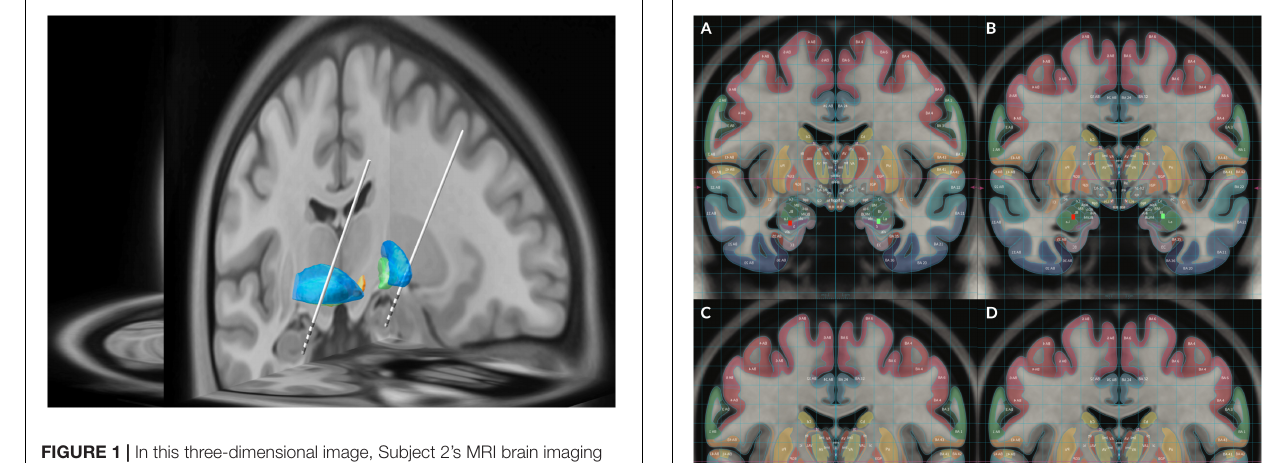
FIGURE 1 | In this three-dimensional image, Subject 2’s MRI brain imaging studies were registered to the MNI space (MNI152 NLIN2009a) and then overlaid on the structural atlas of Mai (Horn and Kühn, 2015; Mai and Majtanik, 2017). Here we demonstrate the trajectory for each DBS electrode implanted into the head of the HC and amygdala as represented in “MNI space.” The blue regions represent the putamen while the green regions represent the globus pallidus. The white lines represent the DBS leads with four gray regions representing individual electrode contacts. See Figure 2 for precise localization of each contact.